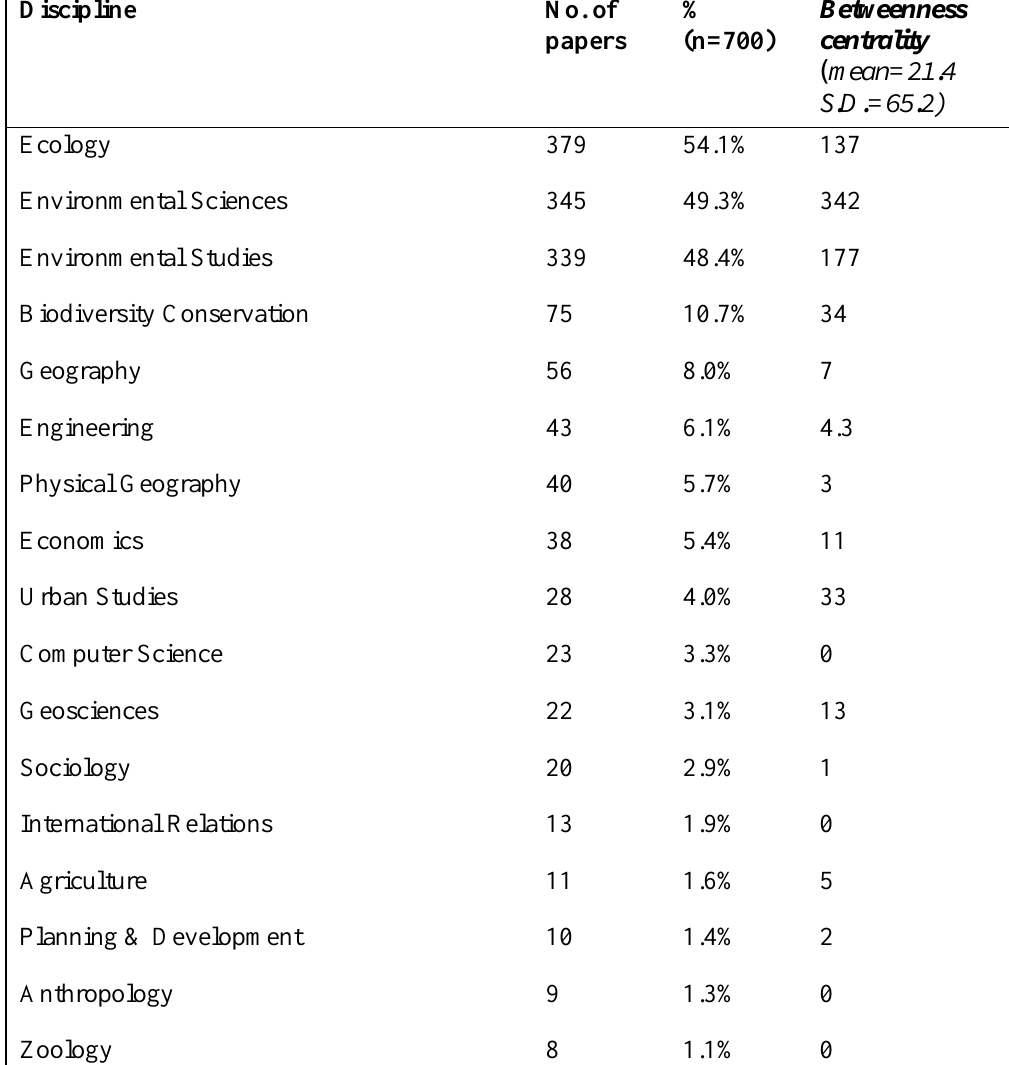
Table A4.5 Representation disciplines in empirical papers and betweenness centrality scores. Analysis was done using the studies identified during the abstract review (n=700) and was based on the classification system used by the Web of Science database, which assigns classification based on